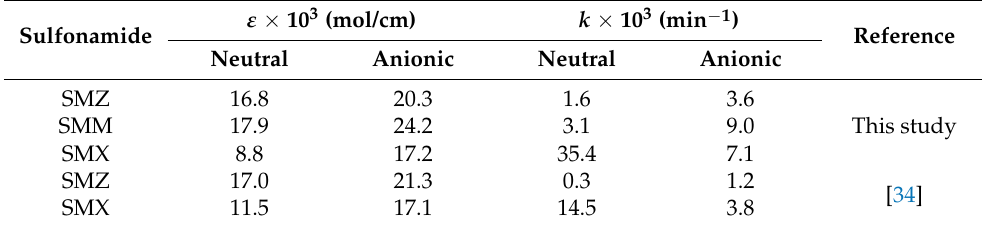
Table 1. Specific parameters of sulfonamide species in the UV system. Sulfonamide